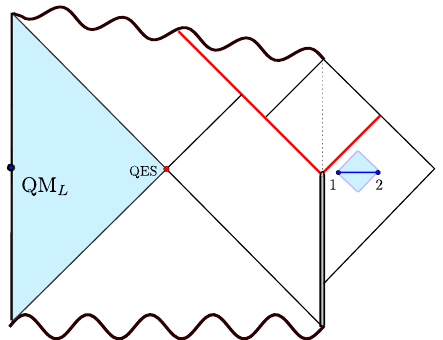
Figure 10. A sketch of the entanglement wedges for the Early phases of the entanglement entropy during early times.